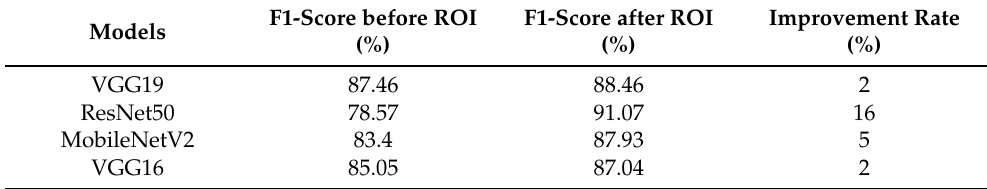
Table 10. Improvement rate after applying the proposed ROI to disc